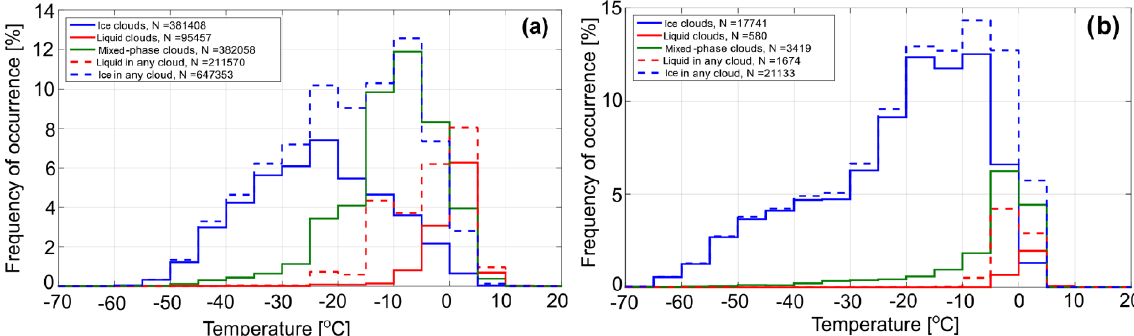
Figure 14. Distribution of in-cloud atmospheric temperature for different types of single-layer clouds, liquid, and ice phase for observa- tions (a) and the NWP ICON model over Ny-Ålesund (b)